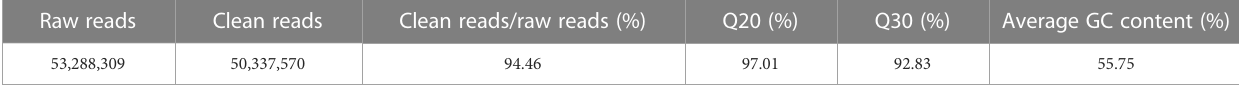
TABLE 1 Summary of the RNA_Seq